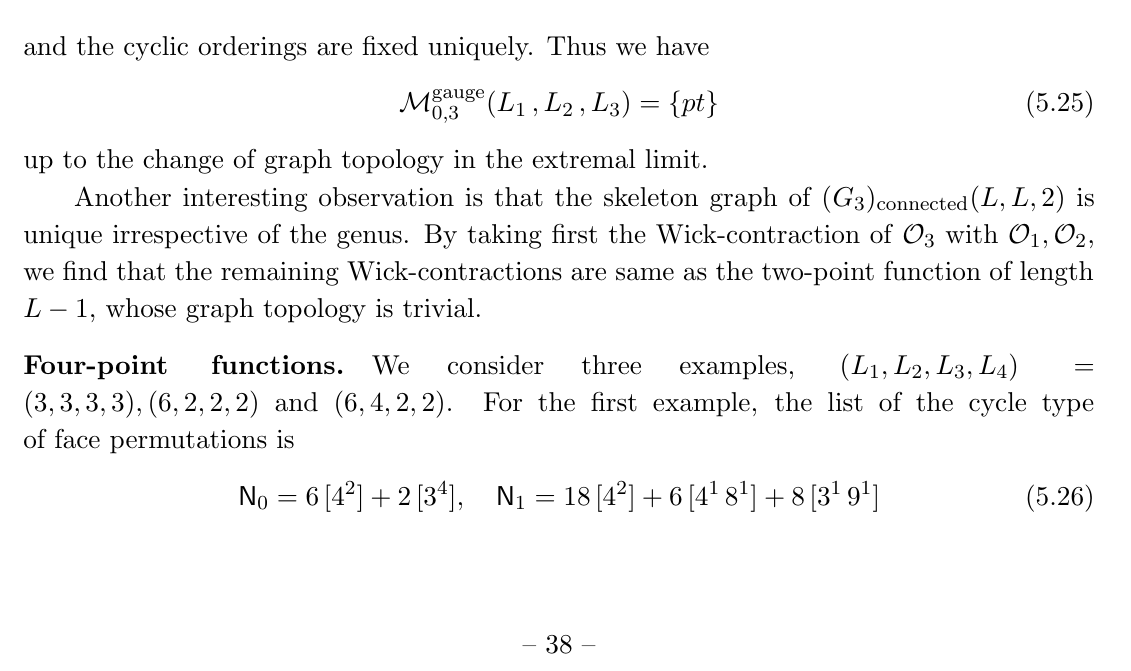
Figure 15 . Examples of toric diagrams in M gauge in the center is extremal and has ‘ 13 =